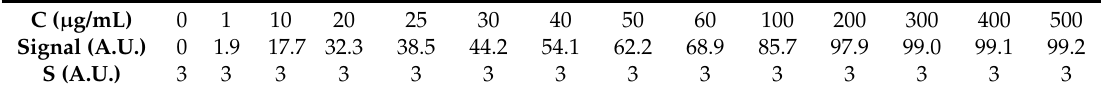
Figure 6. Data, calibration line, uncertainty band, limits of detection and quantification and measuring intervals for the given example.